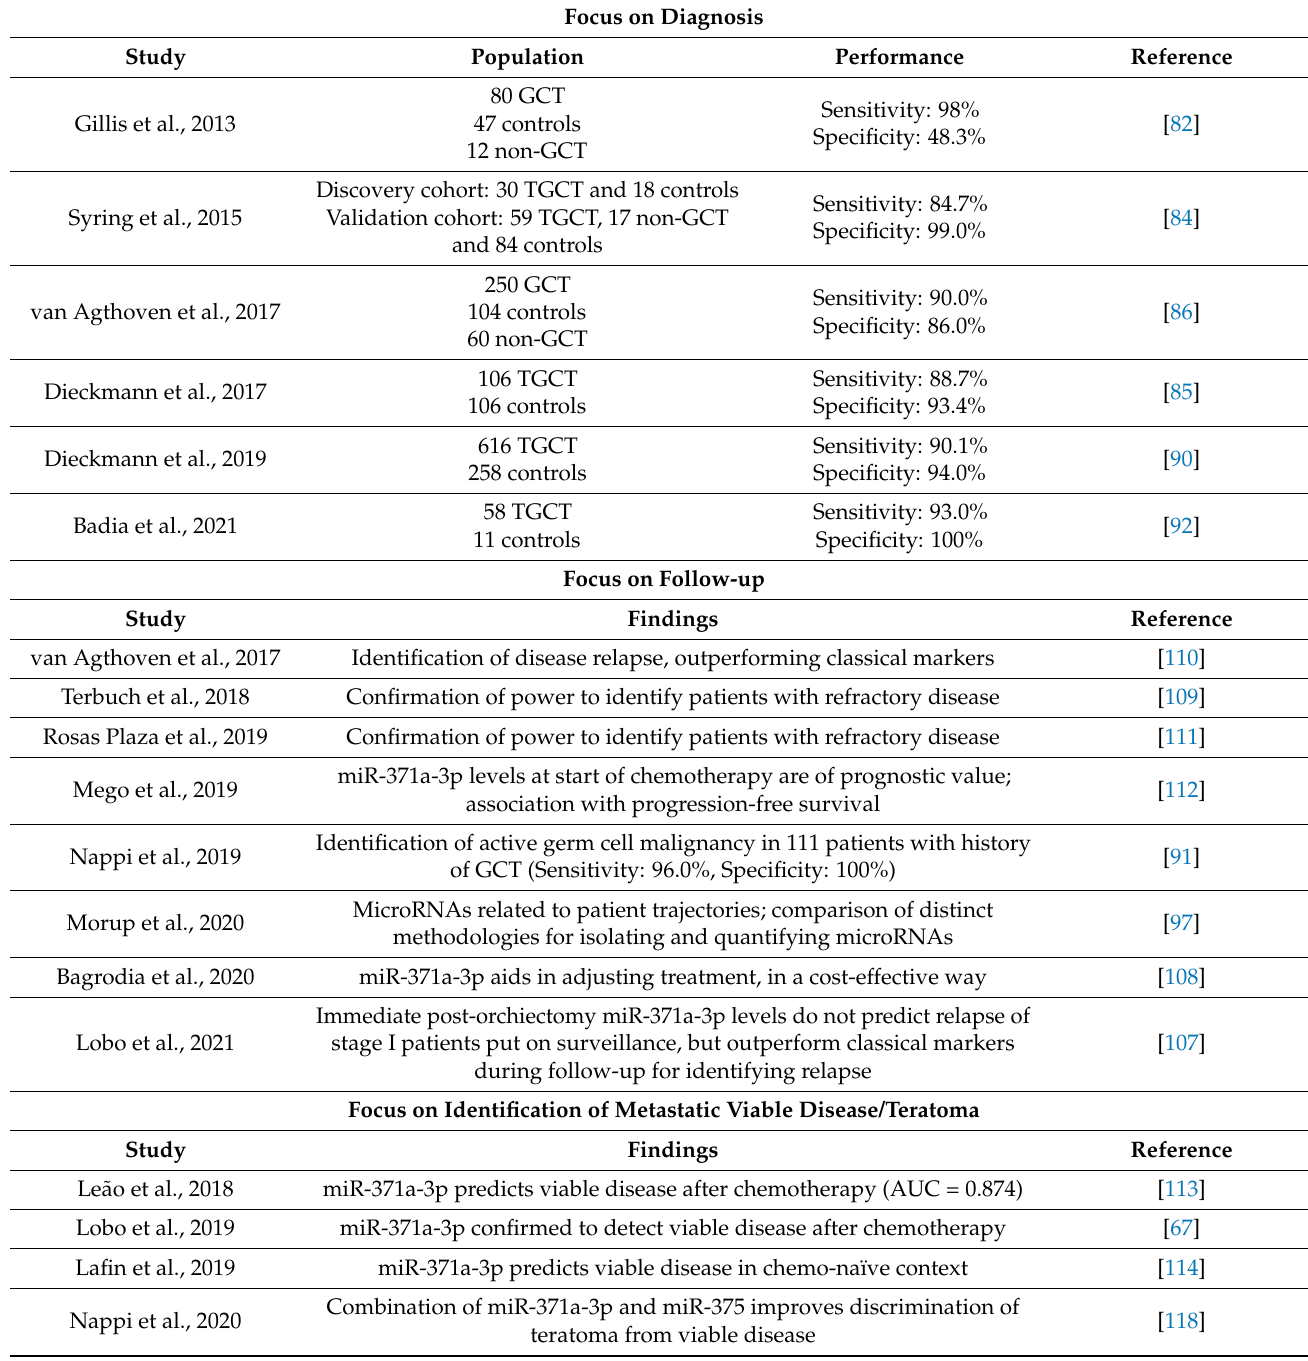
Table 3. Some studies on microRNAs in the field of germ cell tumors, according to design and main